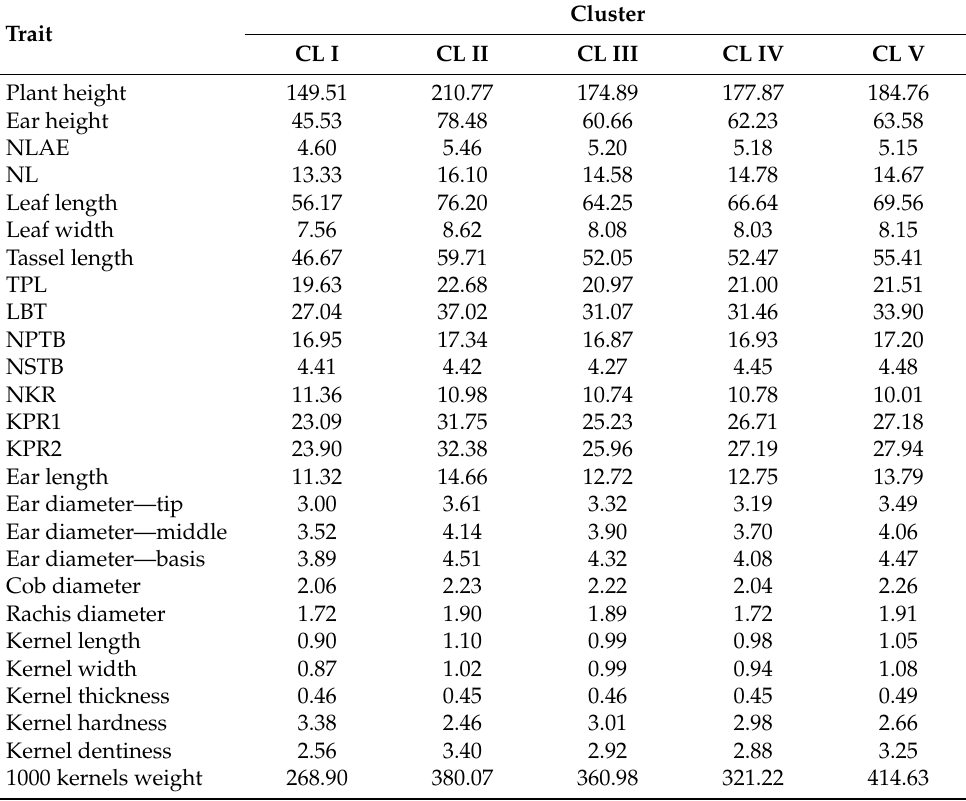
Table 2. Cluster mean values for the measured traits of MRIZPGB white maize landraces.